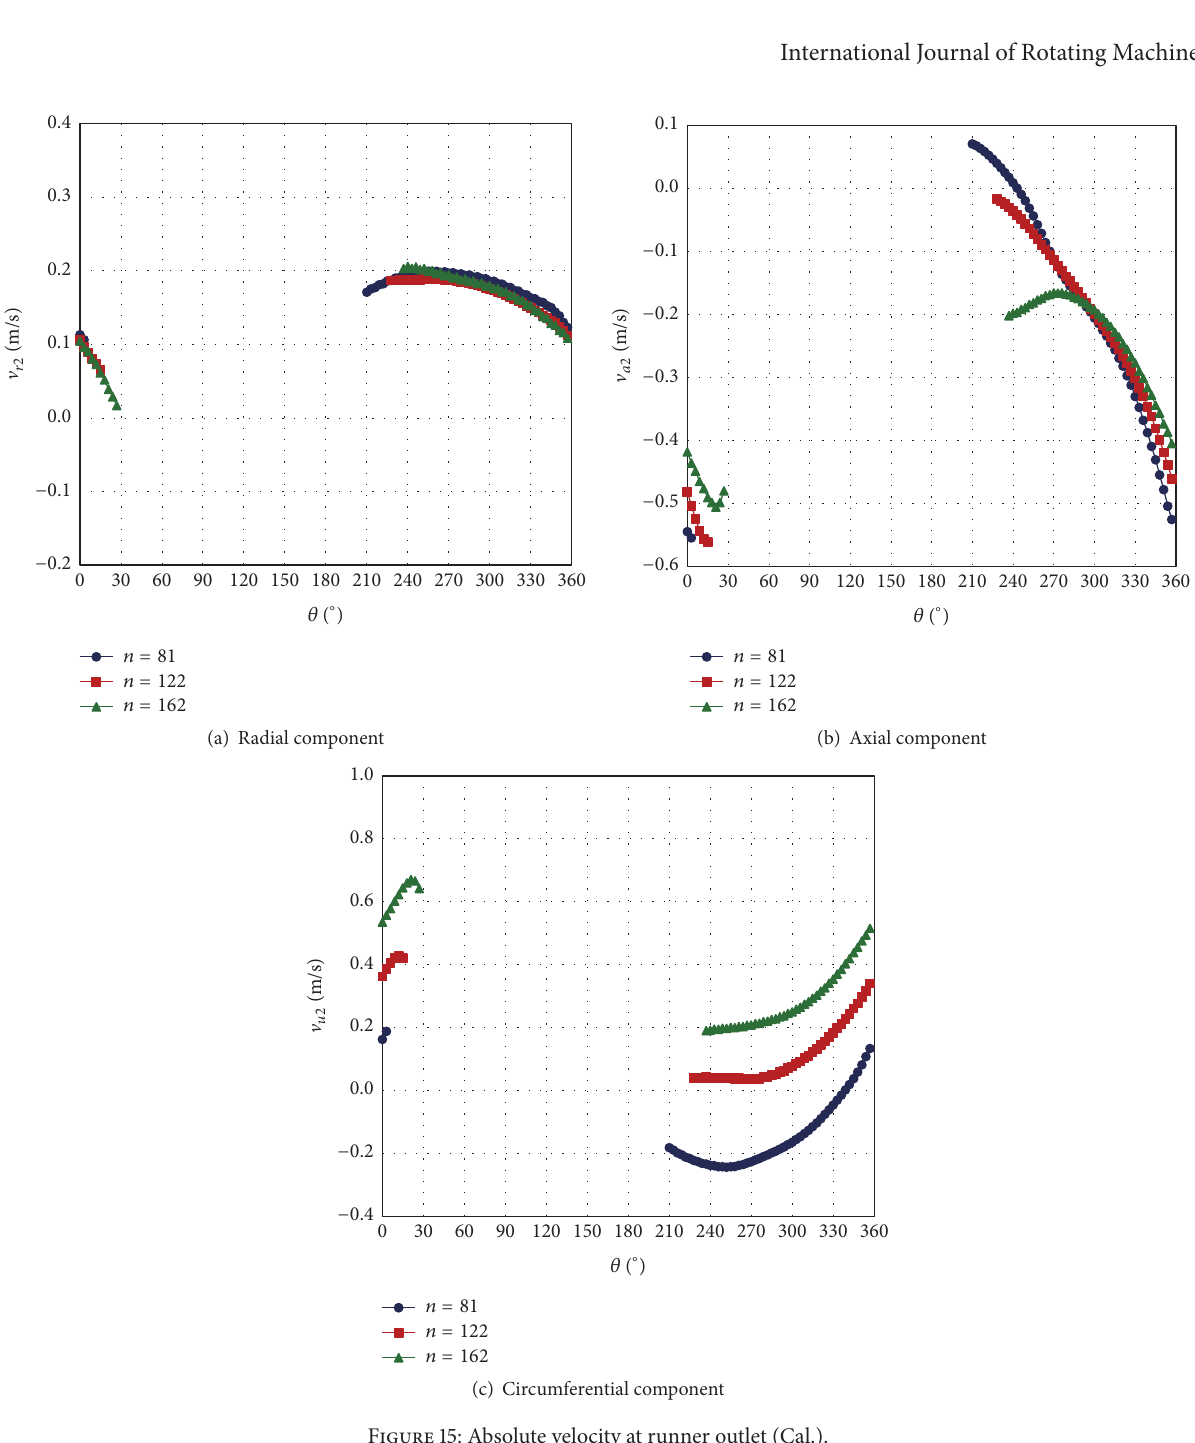
Figure 15: Absolute velocity at runner outlet